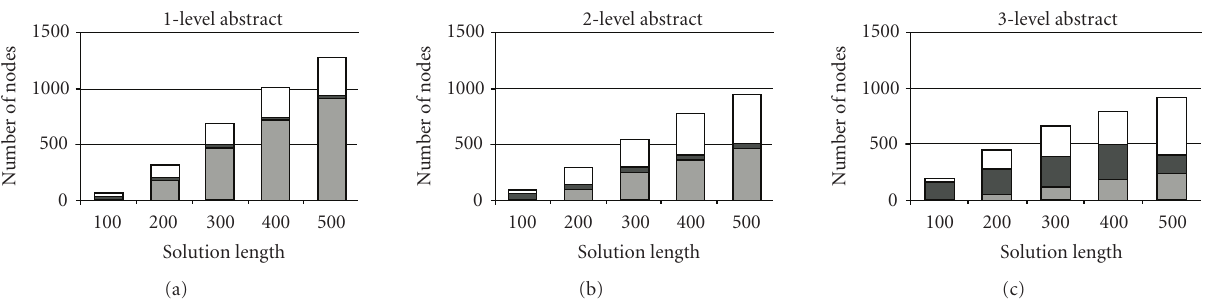
Figure 19: The e ff ort for hierarchical search in hierarchies with one abstract level, two abstract levels, and three abstract levels. We show in what proportion the main e ff ort, the SG e ff ort, and the refinement e ff ort contribute to the total e ff ort. The gray part at the bottom of a data bar represents the main e ff ort. The dark part in the middle is the SG e ff ort. The white part at the top is the refinement e ff